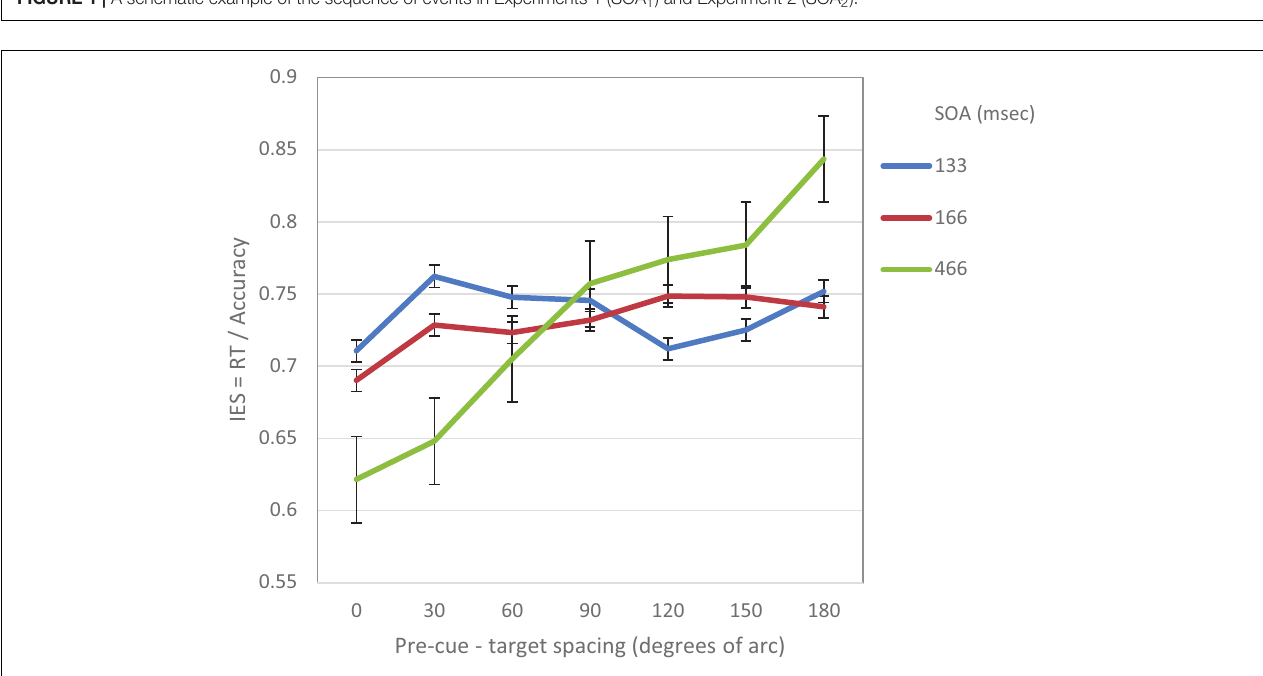
FIGURE 2 | IES (a combined RT-Accuracy measure) in Experiment 1 as a function of pre-cue – target spacing and SOA.